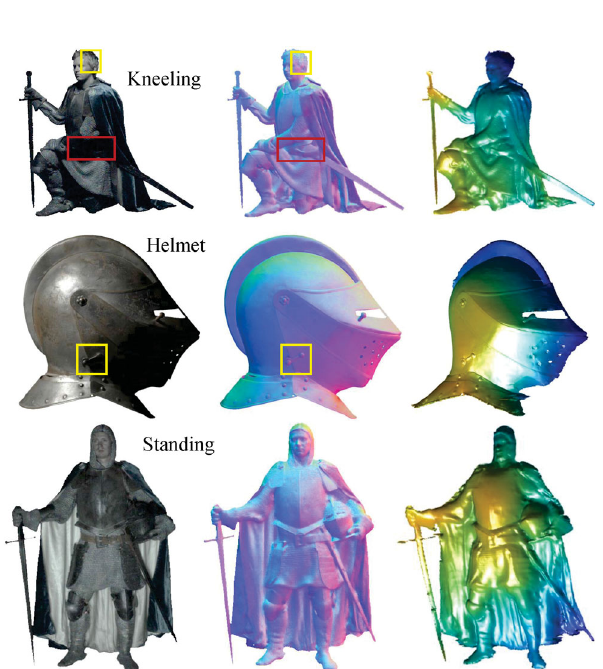
Fig. 6 Qualitative results of our method on objects Kneeling, Helmet, and Standing. Yellow boxes: regions with high-frequency surfaces (such as crinkles). Red boxes: regions with cast shadows. Contrast is adjusted for ease of viewing. After predicting surface normals, 3D reconstructions are recovered by Ref.